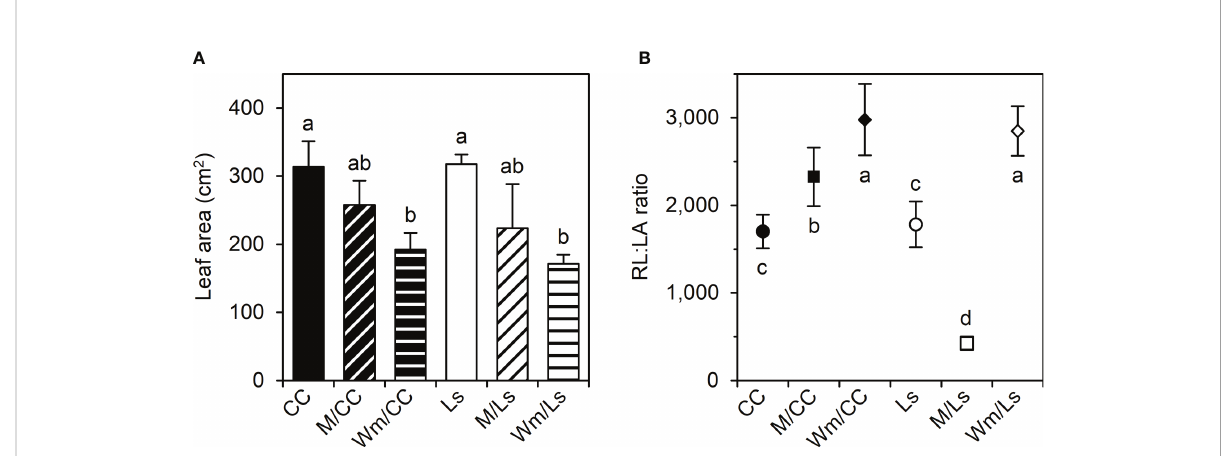
FIGURE 2 (A) Plant leaf area (LA, cm 2 ) and (B) root length-to-leaf area ratio (RL : LA) of self-grafted Cucurbita maxima × Cucurbita moschata (CC), and Lagenaria siceraria (Ls) and of respective heterografts with melon (M) and watermelon (Wm) at day 60 after grafting (DAG 60). Different letters indicate signi fi cant differences within LA and RL : LA, respectively (Tukey test, p < 0.05; mean ±